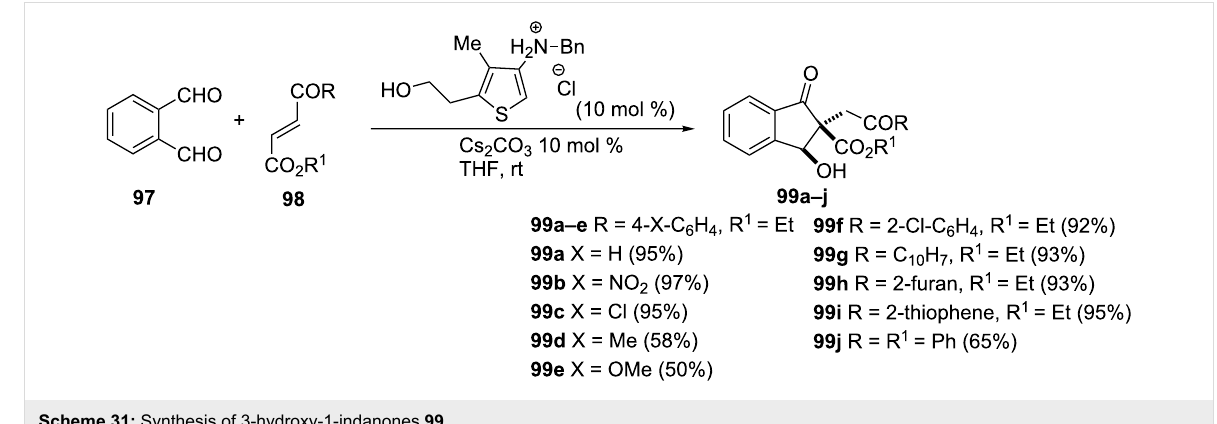
Scheme 31: Synthesis of 3-hydroxy-1-indanones 99 .